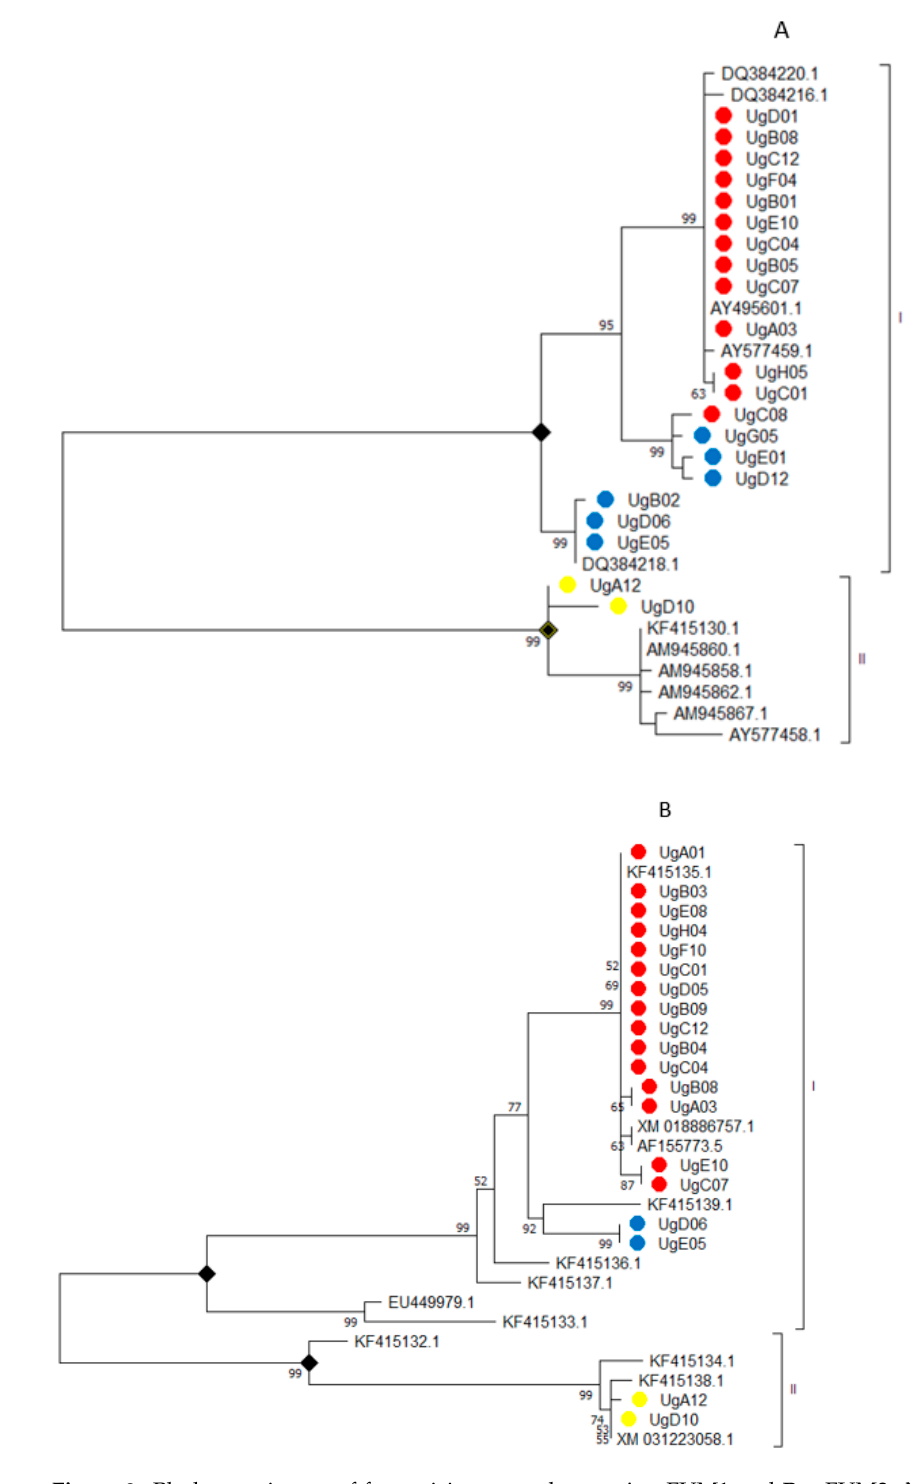
Figure 2. Phylogenetic tree of fumonisins gene cluster. A = FUM1 and B = FUM3. Yellow node ( F. proliferatum ), blue node ( F. andiyazi ), and red node ( F. verticillioides ).